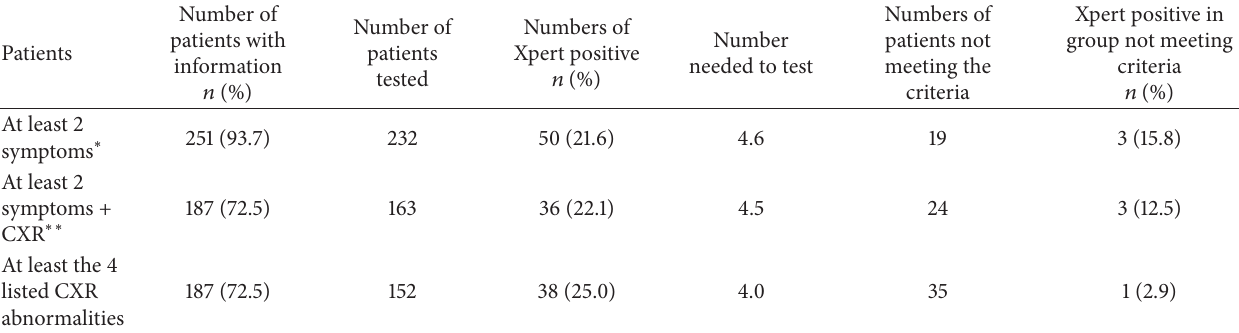
Table 3: Number of patients detected as positive by GeneXpert using different inclusion criteria for